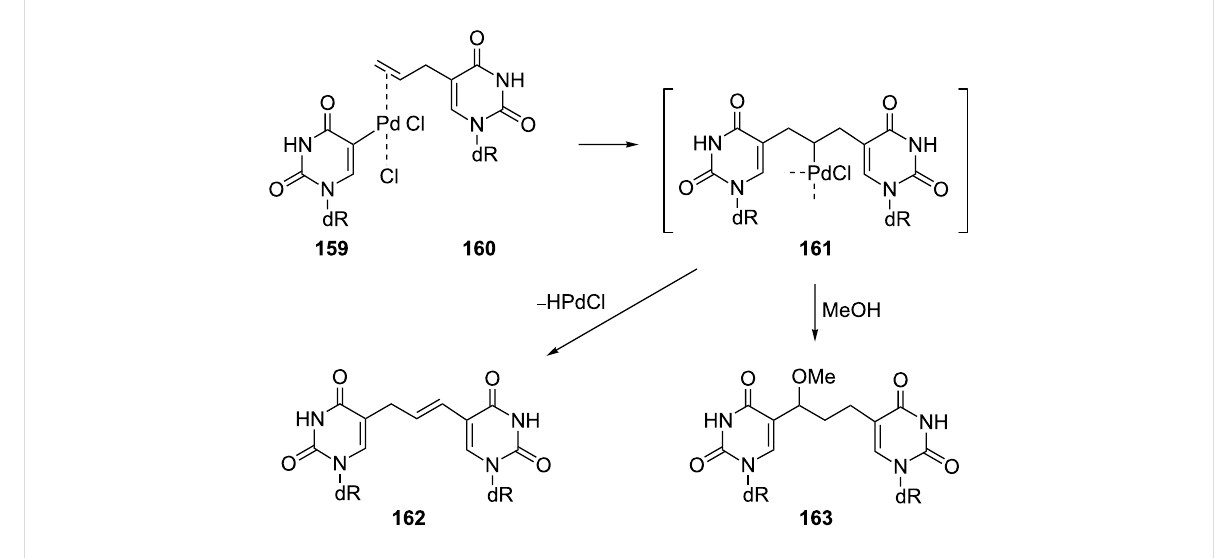
Scheme 27: Synthesis of 5-[3-(2'-deoxyuridin-5-yl)-1-methoxyprop-1-yl]-2'-deoxyuridine ( 163 ).